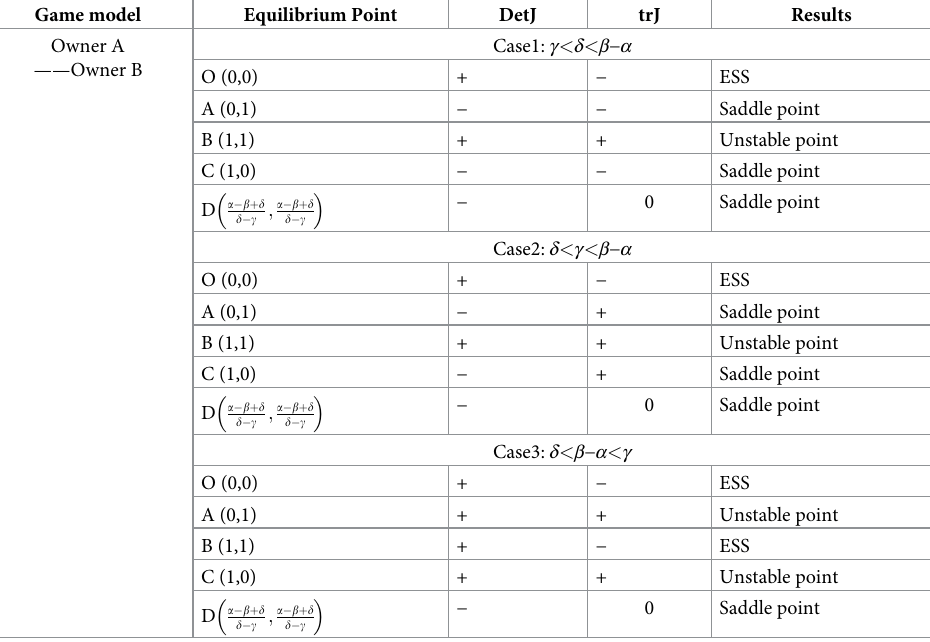
Table 4. Stability analysis results. Game